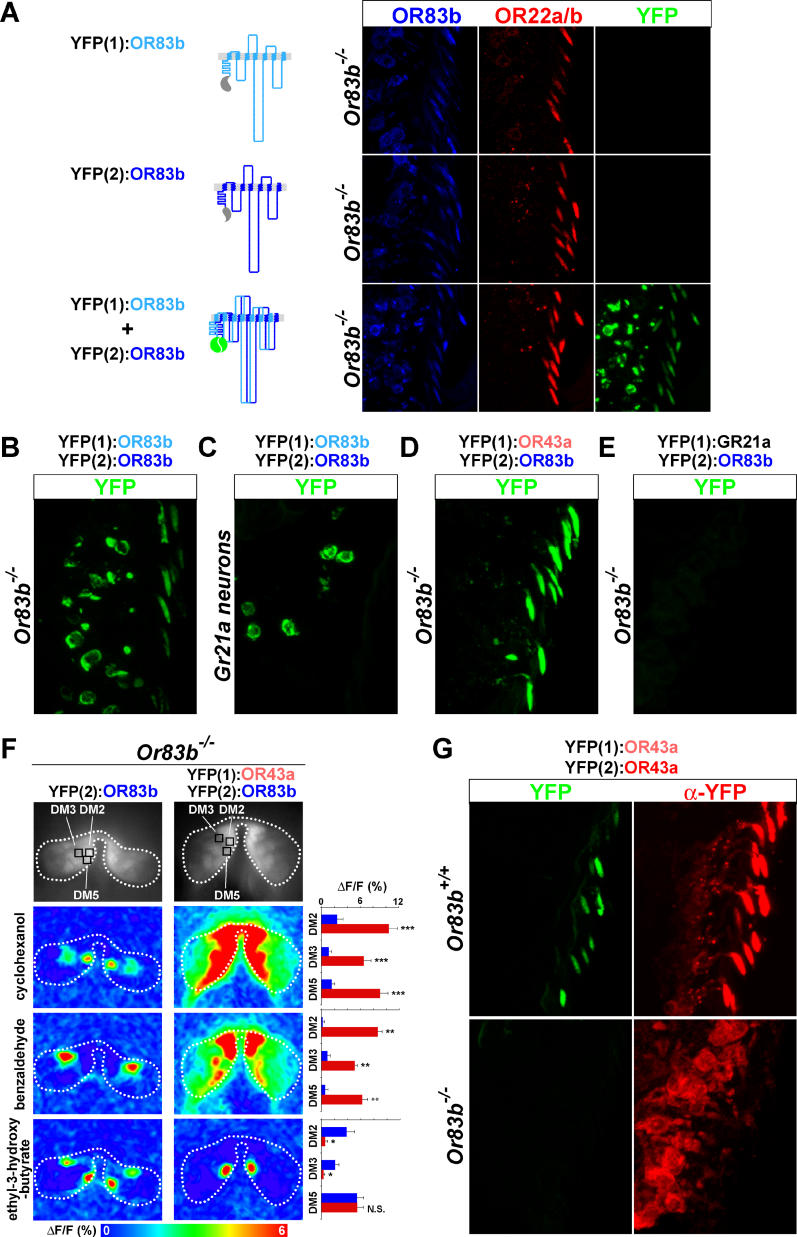
In Vivo Formation and Distribution of OR/OR83b Complexes(A) Immunostaining for OR83b (blue), OR22a/b (red), and intrinsic YFP fluorescence (green) in antennal sections of Or83b null-mutant animals expressing YFP fragment:OR83b fusions, singly or in combination, as illustrated in the snake plots on the left. We note that the snake plots in this and subsequent figures are generated by computational analysis of OR sequences and the exact number and precise placement of the TM domains has not been experimentally verified. Genotypes: Or83b-Gal4/UAS-YFP(1):Or83b;Or83b1/Or83b2 (top row); Or83b-Gal4/+;UAS YFP(2):Or83b,Or83b1/Or83b2 (middle row); Or83b-Gal4/UAS-YFP(1):Or83b;UAS-YFP(2):Or83b,Or83b1/Or83b2 (bottom row).(B–E) Intrinsic YFP fluorescence (green) in antennal sections of animals expressing the indicated combinations of complementary YFP fragment fusions with these genotypes:(B) Or83b-Gal4/UAS-YFP(1):Or83b;UAS-YFP(2):Or83b,Or83b1/Or83b2
(C) Gr21a-Gal4/UAS-YFP(1):Or83b;UAS-YFP(2):Or83b/+
(D) Or83b-Gal4/UAS-YFP(1):Or43a;UAS-YFP(2):Or83b,Or83b1/Or83b2
(E) Or83b-Gal4/UAS-YFP(1):Gr21a;UAS-YFP(2):Or83b,Or83b1/Or83b2
(F) Left column: representative stimulus-evoked calcium signals recorded from the axon terminals of Or83b neurons in the antennal lobe of an Or83b mutant animal expressing YFP(2):OR83b alone (UAS-G-CaMP/UAS-G-CaMP;Or83b-Gal4/+;UAS-YFP(2):Or83b,Or83b1/Or83b2) or YFP(1):OR43a and YFP(2):OR83b (UAS-G-CaMP/UAS-G-CaMP;Or83b-Gal4/UAS-YFP(1):Or43a;UAS-YFP(2):Or83b,Or83b1/Or83b2) as indicated. Top row: intrinsic G-CaMP fluorescence in glomeruli innervated by Or83b neurons. Dotted lines mark the antennal lobe border and the black squares mark the area of the three selected glomeruli (DM2, DM3, and DM5) evaluated for stimulus-evoked changes in fluorescence. Below are false-color-–coded images during stimulation with two characterized OR43a ligands (cyclohexanol and benzaldehyde, both at 10−3 dilution) and a control odor that does not activate OR43a (ethyl-3-hydroxybutyrate, 10−5 dilution) representing ΔF/F (%) according to the scale at the bottom. Right column: quantification of odor-evoked calcium responses in the three indicated glomeruli of animals expressing YFP(2):OR83b alone (blue) or YFP(1):OR43a (red), and YFP(2):OR83b YFP(1):OR43a/YFP(2):OR83b-expressing animals show stronger responses for the known OR43a ligand stimuli (** p < 0.01; *** p < 0.001). DM2 and DM3 glomeruli show reduced responses to the control odor (* p < 0.05) similar to the effects of ectopic OR expression on the endogenous CO2 responses of Gr21a neurons (Figure 6), while DM5 activity does not differ significantly between genotypes (marked N.S. on the bar graph). Significance was assessed with a two-tailed unpaired t-test; n = 4 animals per genotype and stimulus. CAS Registry Numbers: cyclohexanol (108–93–0), benzaldehyde (100–52–7), ethyl-3-hydroxybutyrate (54058–41–4).(G) Intrinsic YFP fluorescence (green) and immunostaining for YFP (red) in antennal sections of animals expressing YFP(1):OR43a and YFP(2):OR43a in control heterozygous (Or83b-GAL4/UAS-YFP(1):Or43a;UAS-YFP(2):Or43a,Or83b1/+ [top panel]) and homozygous (Or83b-GAL4/UAS-YFP(1):Or43a;UAS-YFP(2):Or43a,Or83b1/Or83b2 [bottom panel]) Or83b null-mutant animals.